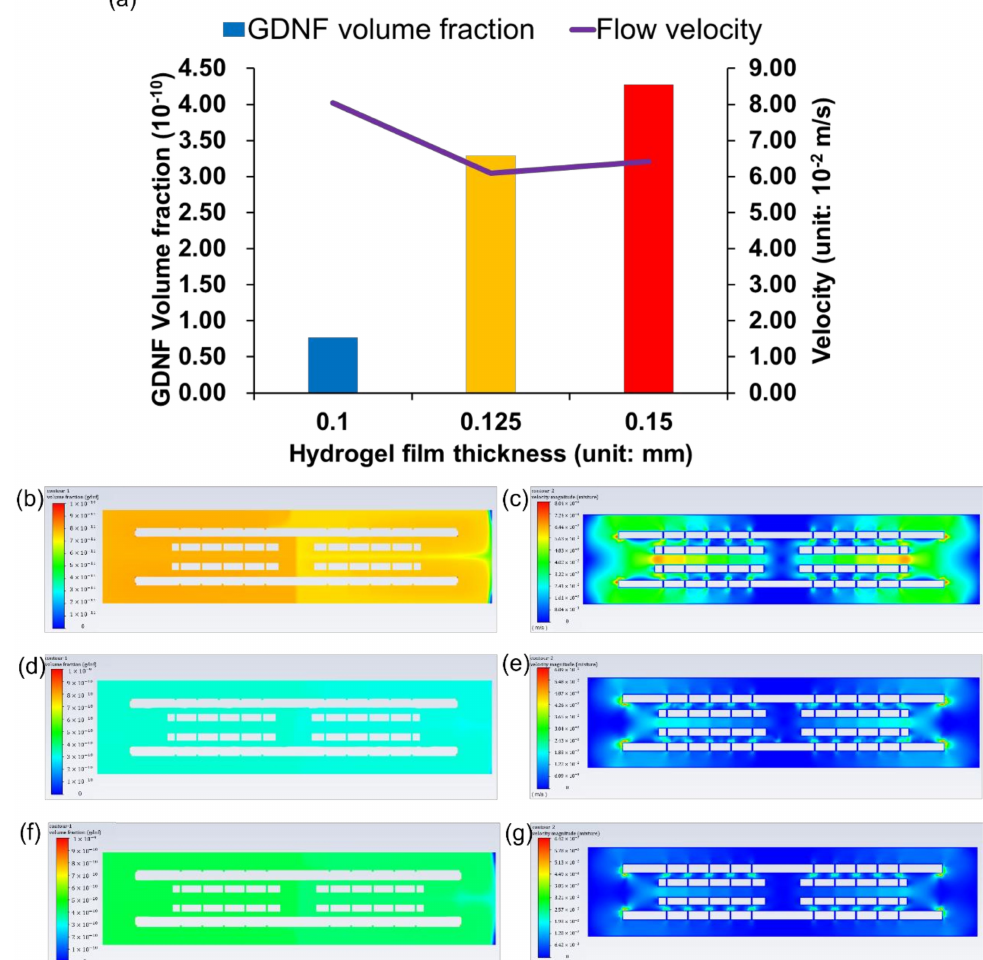
Figure 7. ( a ) GDNF volume fraction and flow velocity of hydrogel film systems with different film thicknesses. ( b , d , f ) GDNF distribution of three hydrogel film systems with film thicknesses from 0.1 mm to 0.15 mm. ( c , e , g ) Flow velocity of three hydrogel film systems with film thicknesses from 0.1 mm to 0.15